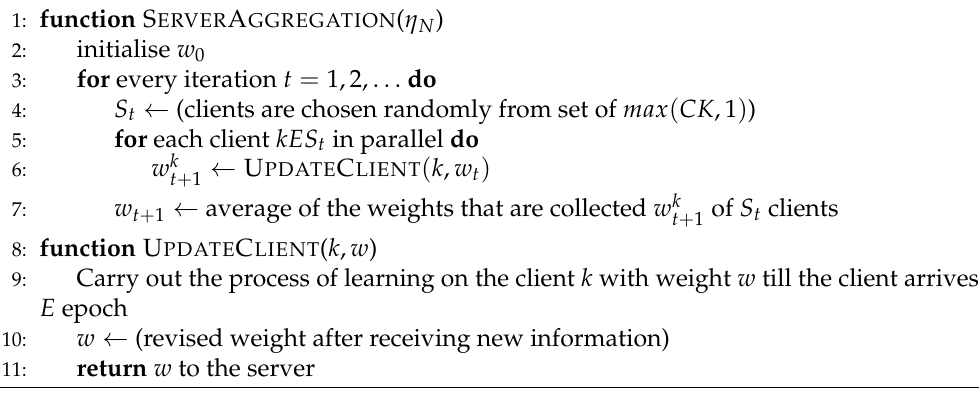
Algorithm 1 FedAvg algorithm; K = no. of clients; E = Epochs served for the whole client; Clients can be chosen based on their C-ratio.